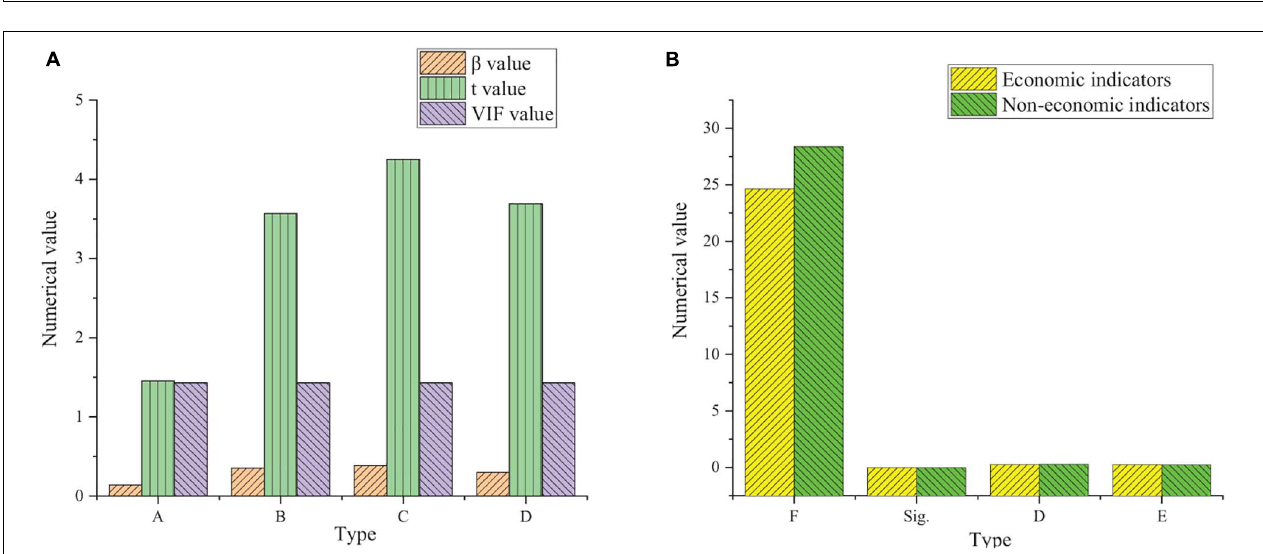
indicators of entrepreneurial performance, with F value of 24.636,